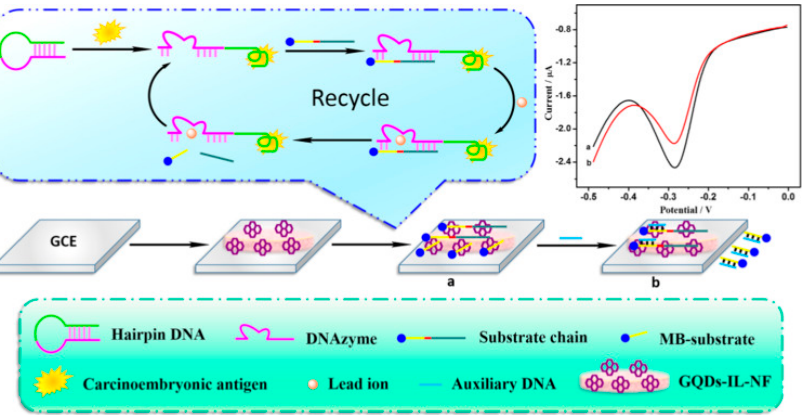
Figure 6. GQDs − IL − NF nanomatrix and DNAzyme − assisted recycling of target-aptamer complex for the sensitive electrochemical detection of CEA. Reprinted from Biosensors and Bioelectronics, ref [108], copyright (2018), with permission from Elsevier. ( a ) conjugation of GQDs with DNAzyme chain, ( b ) addition of MB substrate.